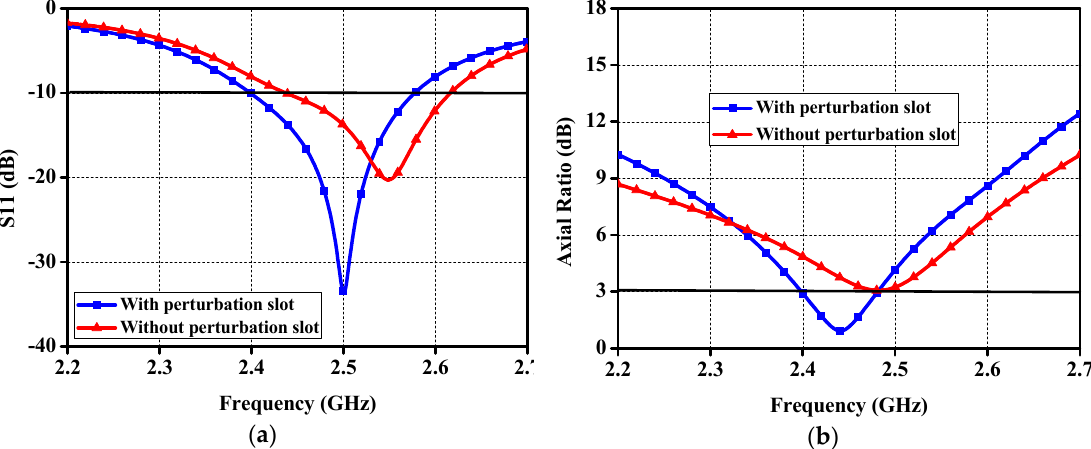
Figure 8. Performance of the proposed antenna with/without perturbation slots: ( a ) Reflection coefficient; and ( b ) AR.